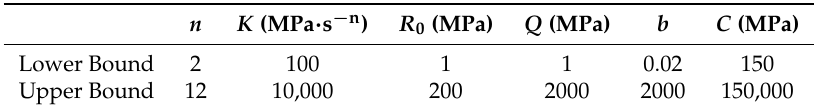
Table A1. Parameter range of variations considered in the model. When applicable, the unit is indicated between brackets. Note that the dimension of K depends on the parameter n according to Equation (A2). n K (MPa · s − n